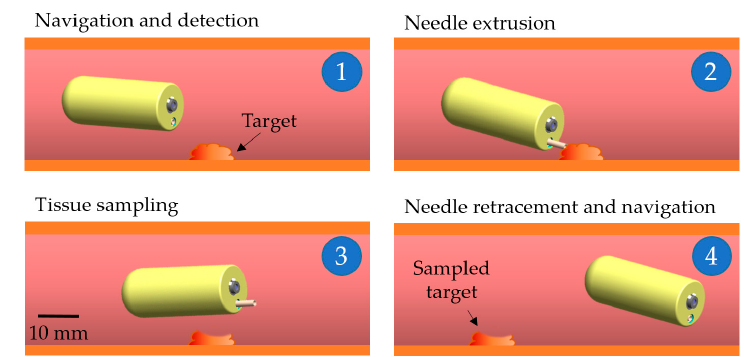
Figure 3. Application scenario of the proposed punch-biopsy CE in the intestine.